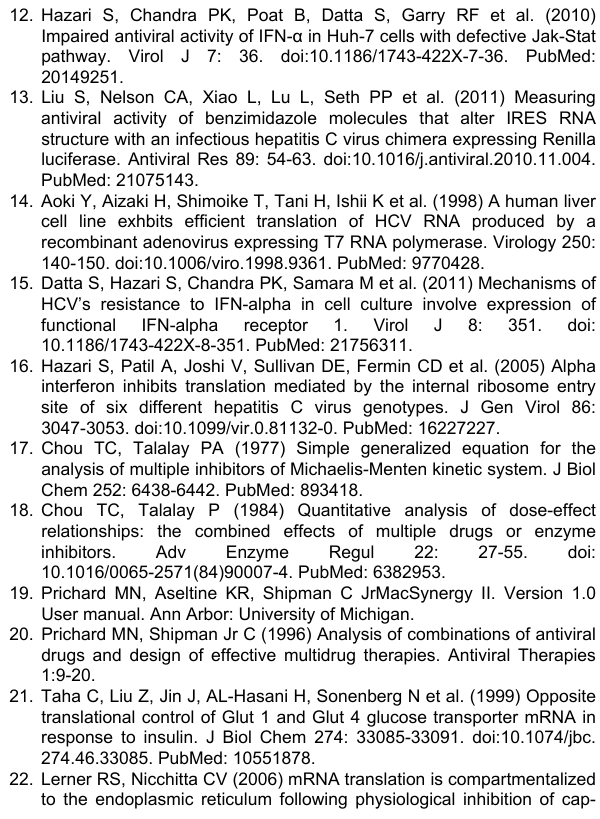
Figure S3. Effect of IFN-α and RBV treatment on (A) GFP and (B) Red fluorescence protein (RFP) expression by non-IRES